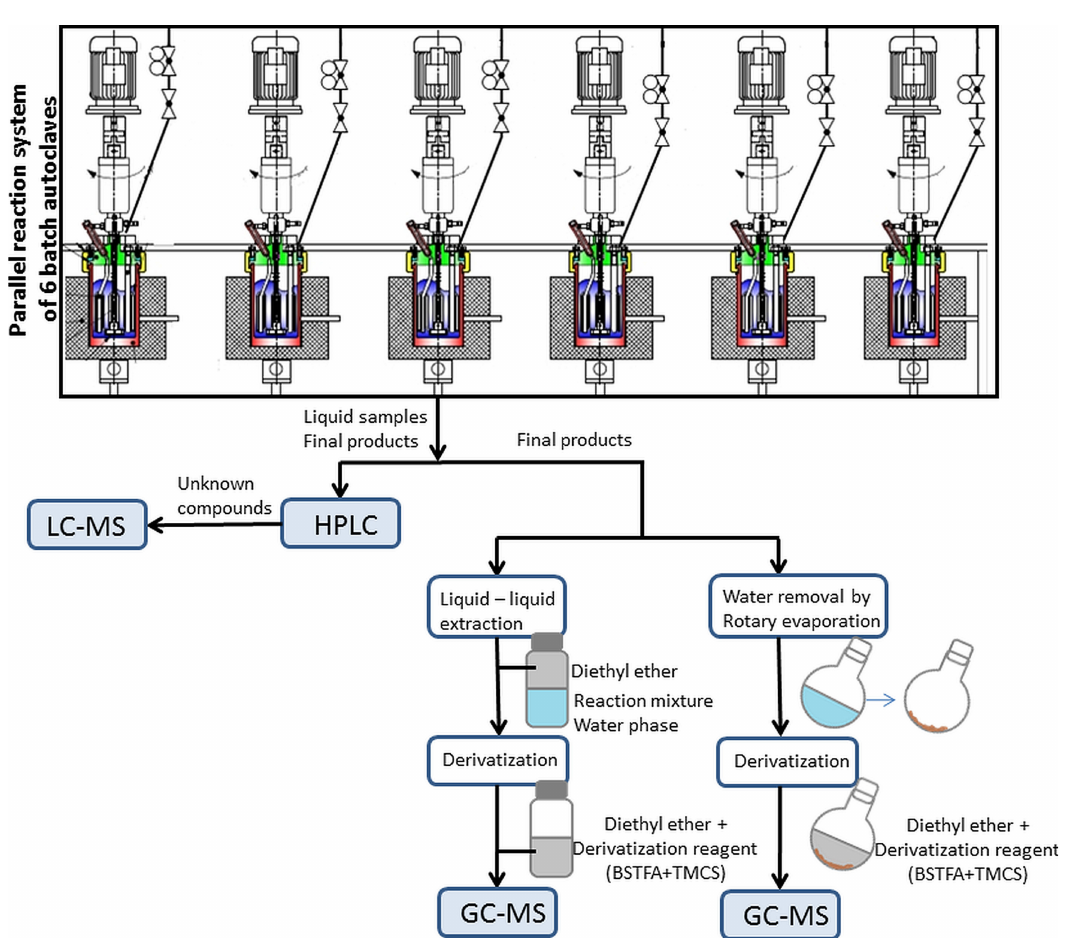
Figure 7. A parallel reaction system of 6 batch reactors and analytic methods with additional sample